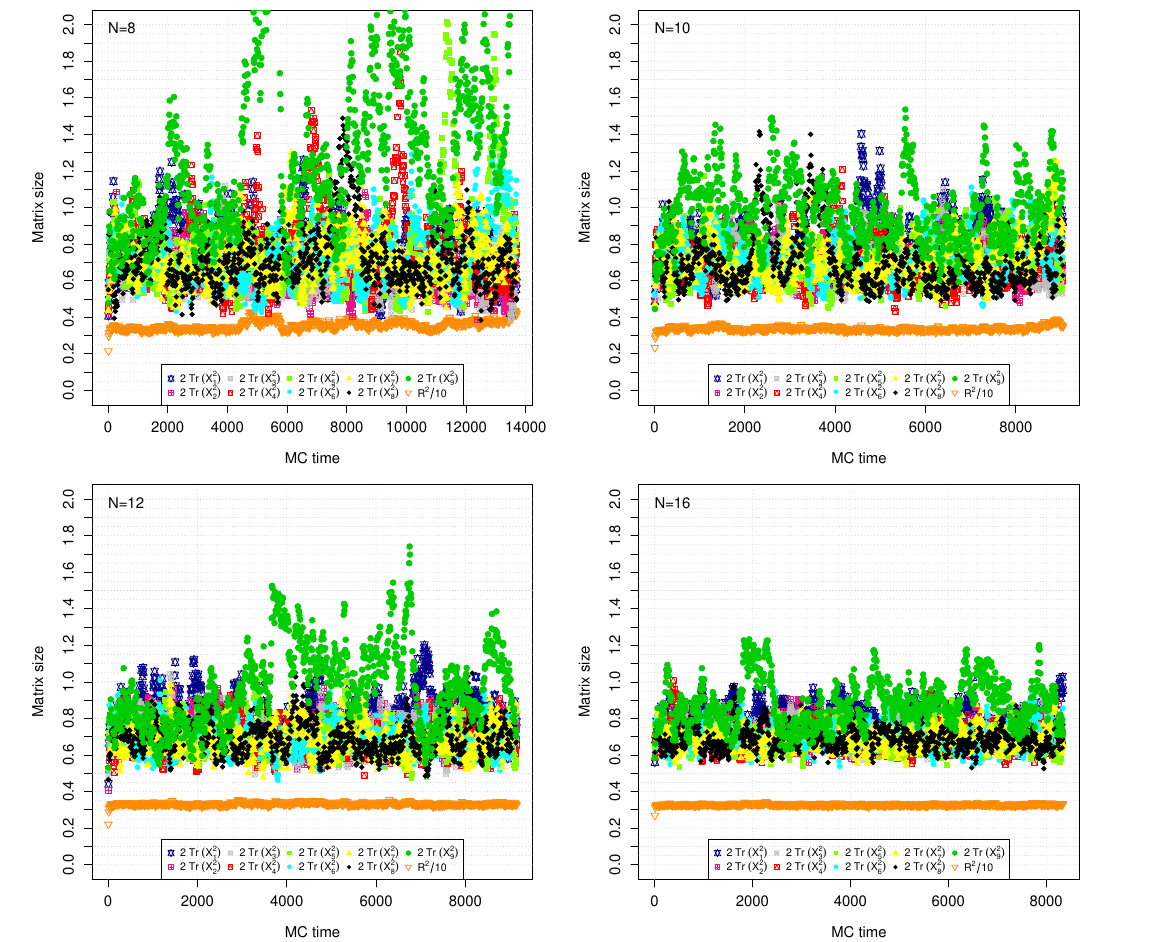
Figure 5 . Monte Carlo histories with T = 0 . 3 , µ = 0 . 5 , L = 30 , N = 8 , 10 , 12 , 16 . We observe temporary increases in Tr X 2 more frequently and strongly at lower N . Some green data points for N = 8 are above the plotting